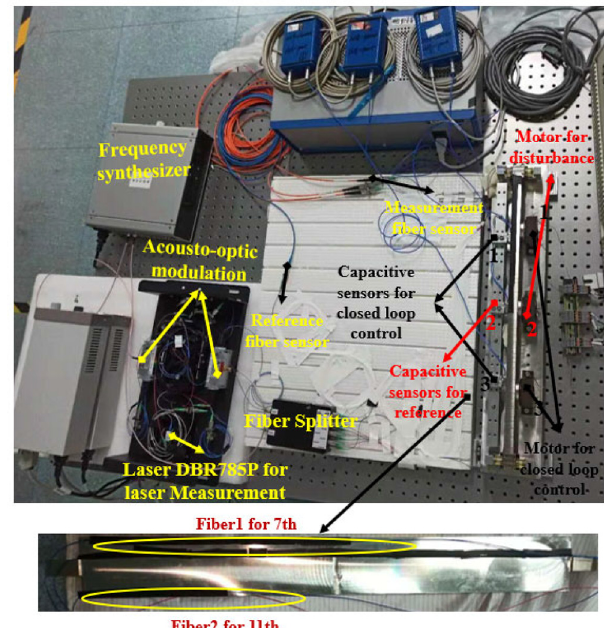
Fig. 7. Experimental